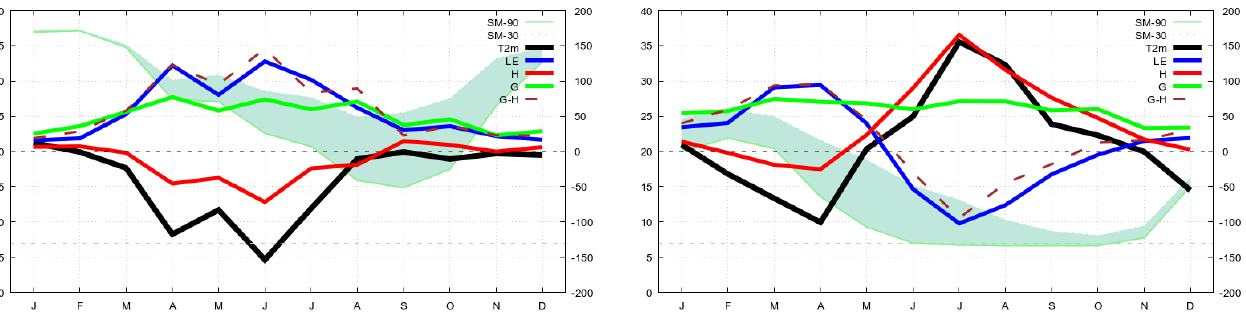
Figure 9. Monthly mean differences at midday between FVC90 and FVC30 experiments for temperature ( ◦ C × 10 2 ) and latent, sensible and ground heat fluxes (W/m 2 , left y-axis) . Shaded green area represents the differences of the soil moisture at the third layer of the soil model (%, right y-axis). FVC90 has always the lower value. The constant dashed green-light line represents the wilting point. Left (right) panel shows the results for N1